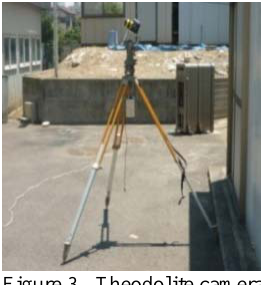
Figure 3. Theodolite camera